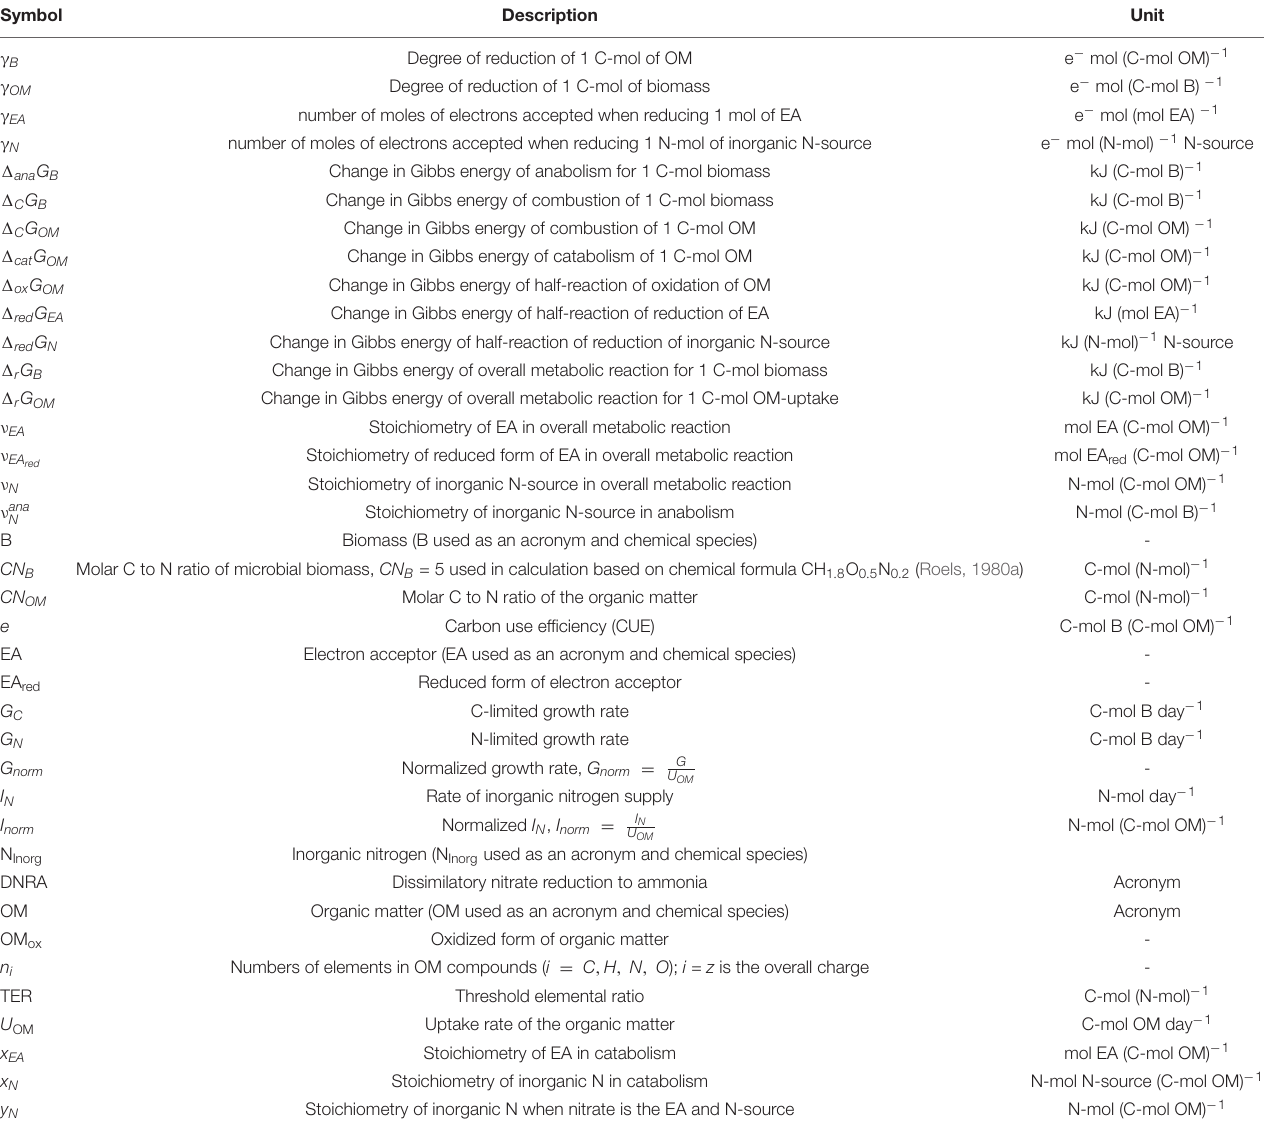
TABLE 1 | List of symbols and acronyms with their descriptions and units. Symbol